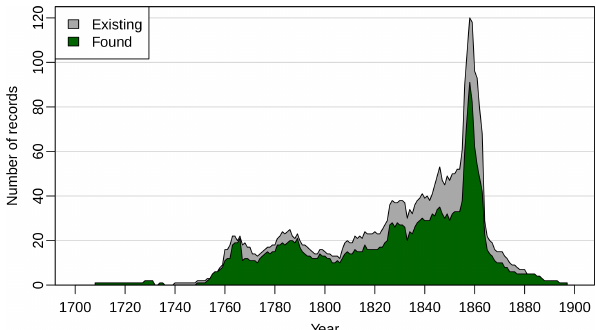
Figure 2. Number of possibly available measurement series (grey) and number of series for which subdaily data were found (green) as a function of the year. The peak around 1860 is due to the Brügger network in Grisons, encompassing around 90 locations. From 1864 onwards, only series starting prior to this date that have not been included in the national network are depicted.